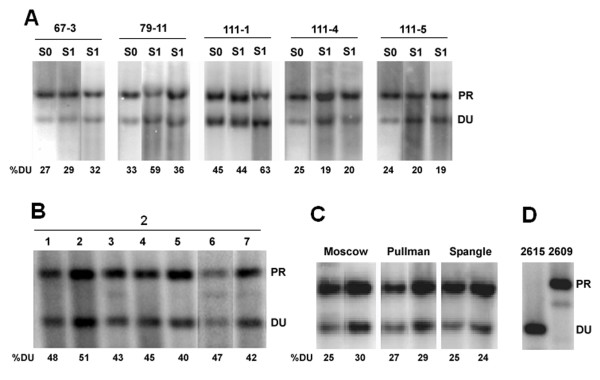
rDNA repeat inheritance in T. miscellus determined by Southern blot hybridization. (A) Synthetic allotetraploid lines of T. miscellus. (B) Diploid T. pratensis x T. dubius hybrids. (C) Natural populations of T. miscellus. (D) Profiles of parental diploids. Representative individuals are shown in the panels; the rest of the analysis expressed as a ratio of parental bands is shown in Figure 5B. The digests and conditions of the blot and labels are the same as in Figure 2. DU - T. dubius units; PR - T. pratensis units.